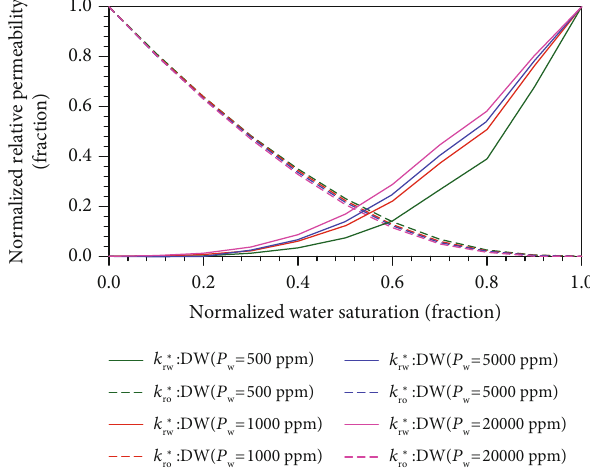
Figure 3: Normalized oil-water relative permeability curves under di ff erent S or .